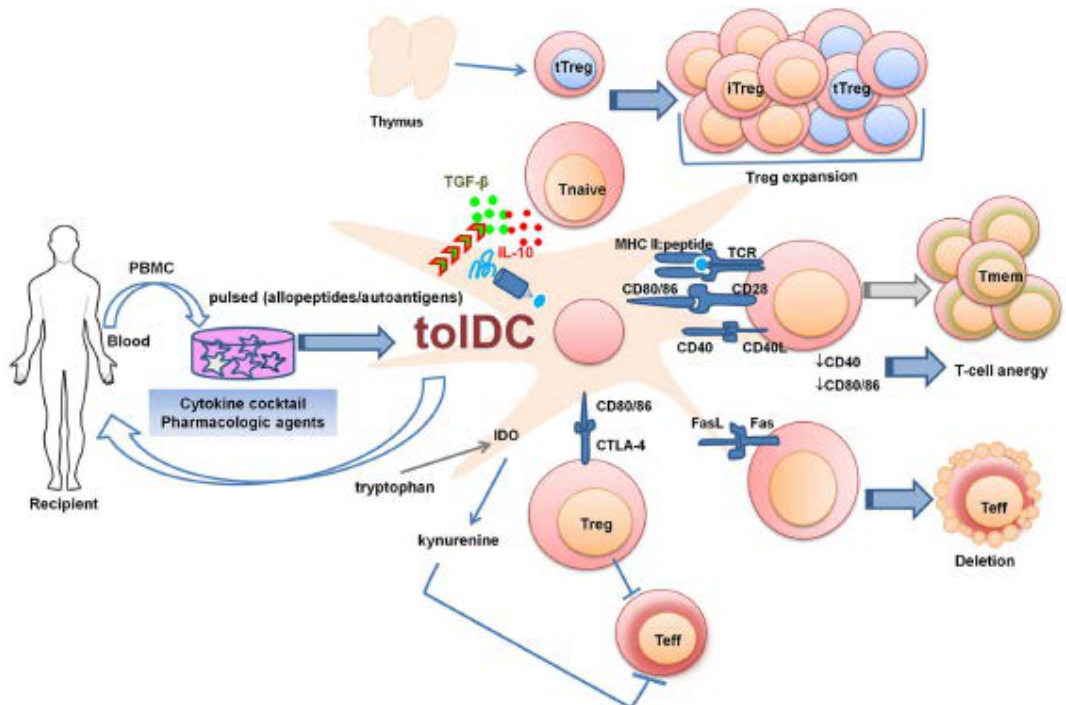
Figure 8. Strategies to generate tolDCs for clinical therapeutics [153].